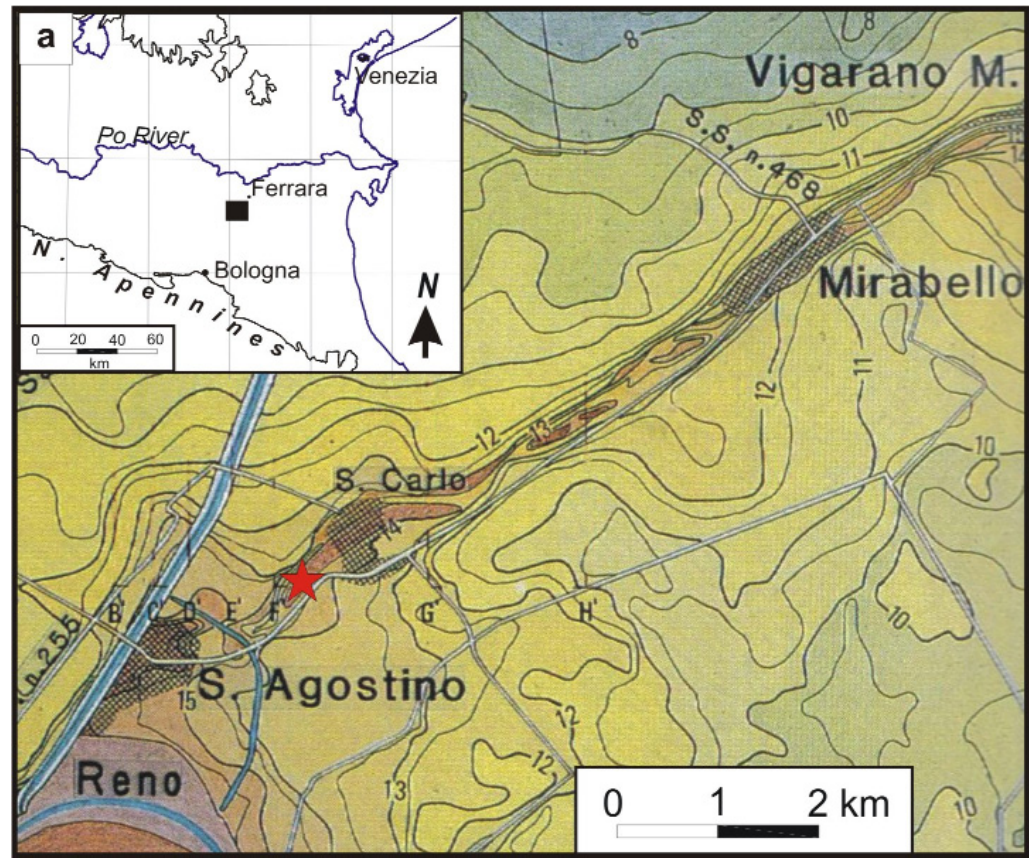
Figure 1. Detailed topographic map (contours every 0.5 m; different colors indicate altitudes as meters a.s.l.) of the western Ferrara Province, showing the relief associated with the paleo-reach of the Reno River from Sant'Agostino to Vigarano Mainarda. Modified from Graziani et al. [1992]. Red star, lo- cation of the trench investigated in this study (44˚47'56"N, 11˚24'05"E); black box in (a), location of the topographic map in northern